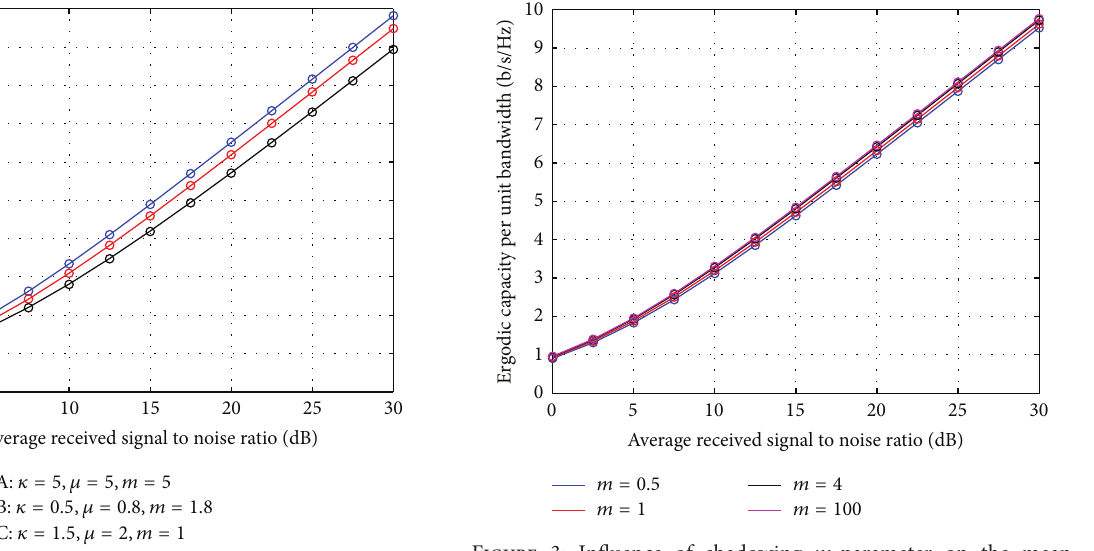
Figure 3: Influence of shadowing 𝑚 -parameter on the mean capacity values when the dominant component has the same power as the scattered waves ( 𝜅 = 1 ). The value of 𝜇 -parameter is set to 3 in all curves. The marks correspond to results obtained by numerical simulation.